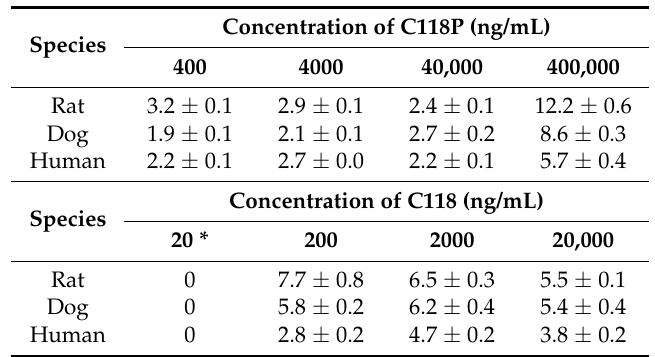
Table 1. The fu values of C118P or C118 in rat, dog, and human plasma (%, mean ± SD).